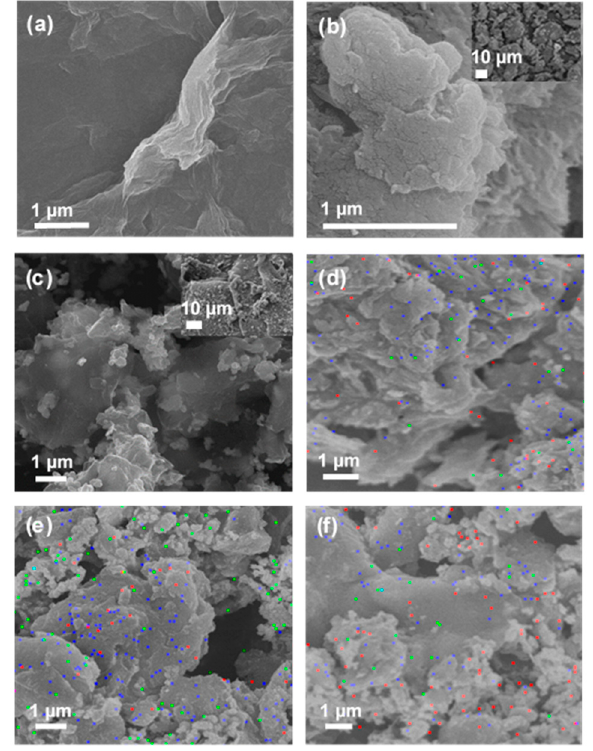
Figure 1. The field emission scanning electron microscope (FESEM) images of ( a ) pristine graphene oxide (GO); ( b ) thiol grafted graphene oxide (GO–SH); and ( c ) GO-Ag 0.2 M composites; FESEM mapping of ( d ) GO-Ag 0.1 M; ( e ) GO-Ag 0.2 M; and ( f ) GO-Ag 0.25 M composites. The red, blue, and green colors represent the elemental distributions of Ag, C, and O.